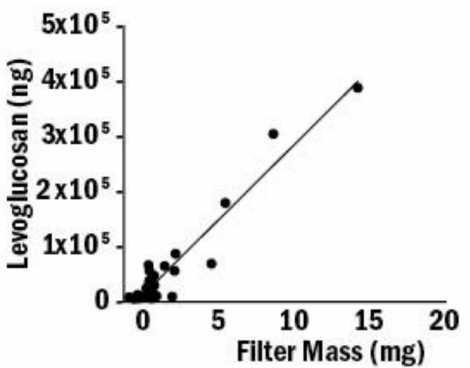
Figure 3. Linear association between levoglucosan and filter mass. Levoglucosan was extracted from the filter, and the amount of levoglucosan was determined by GC-MS analysis from the filter extraction solution. The level of levoglucosan was associated with filter mass, R 2 = 0.92, p =< 0.01.